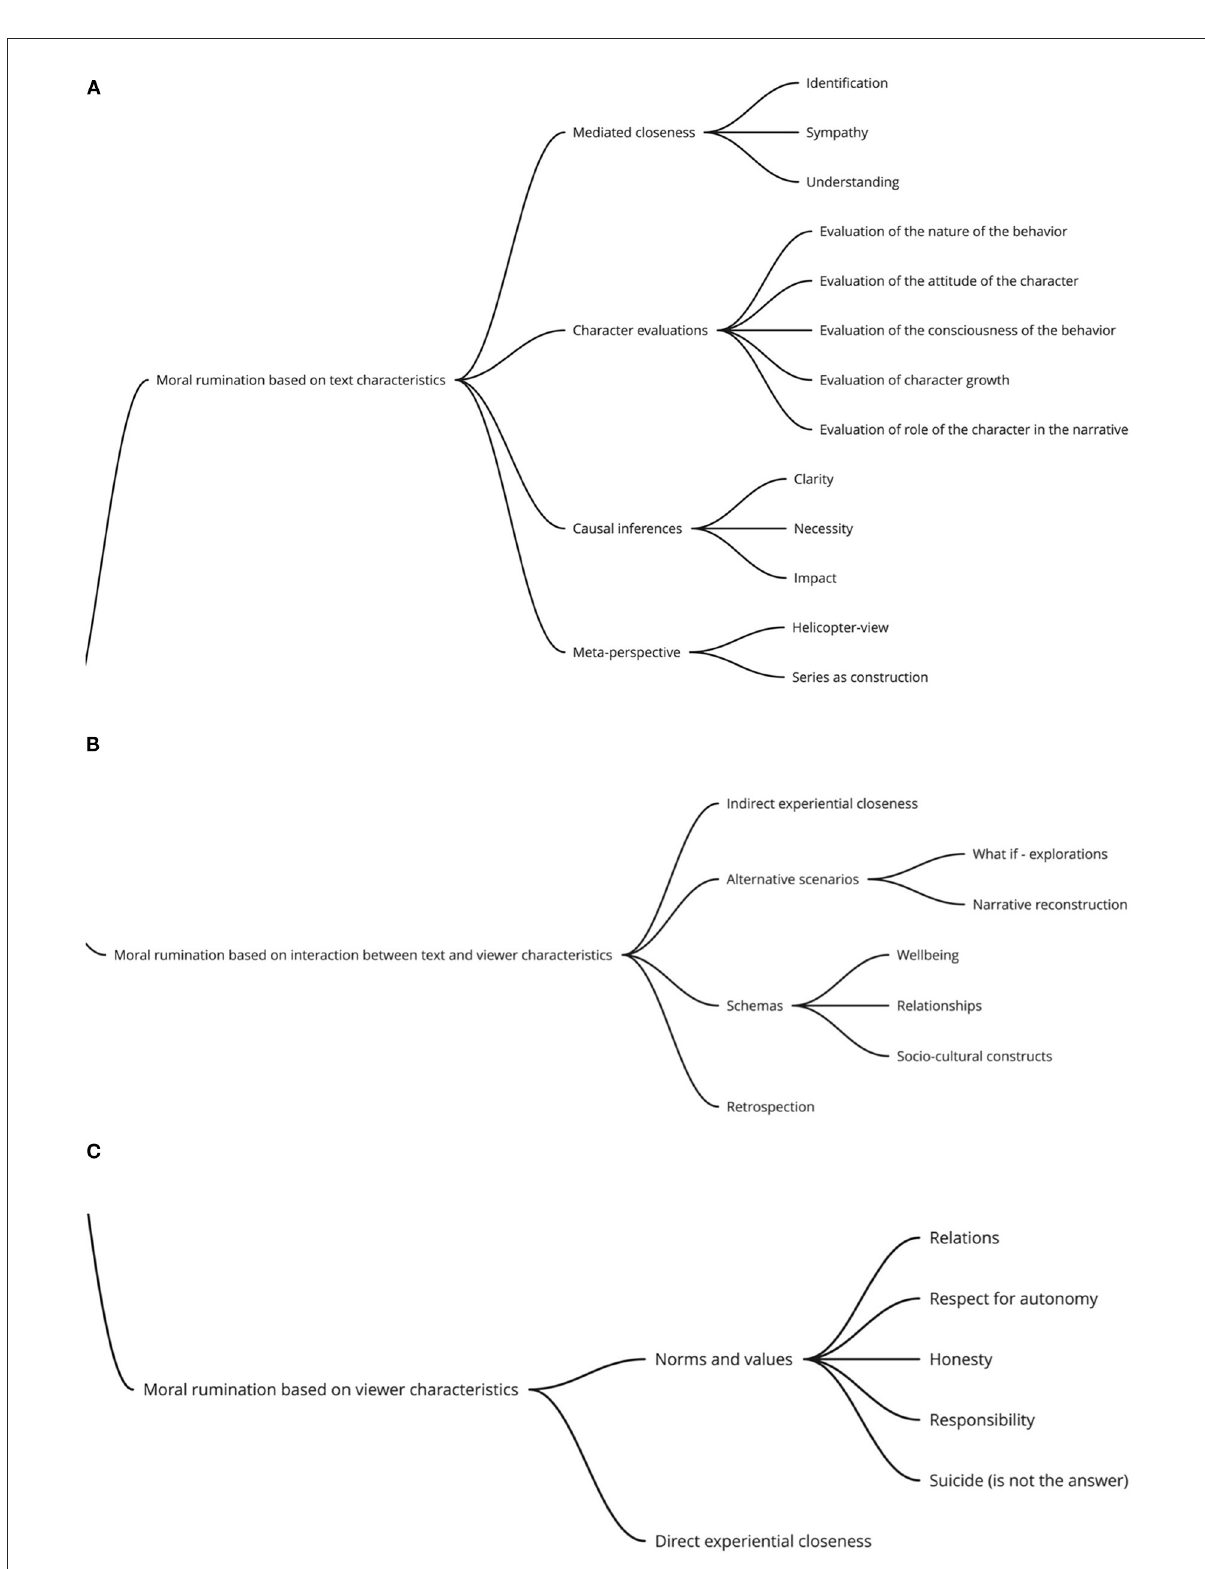
FIGURE2 Moral rumination prompted by text characteristics (A) , the interaction between text and viewer characteristics (B) , and viewer characteristics (C)